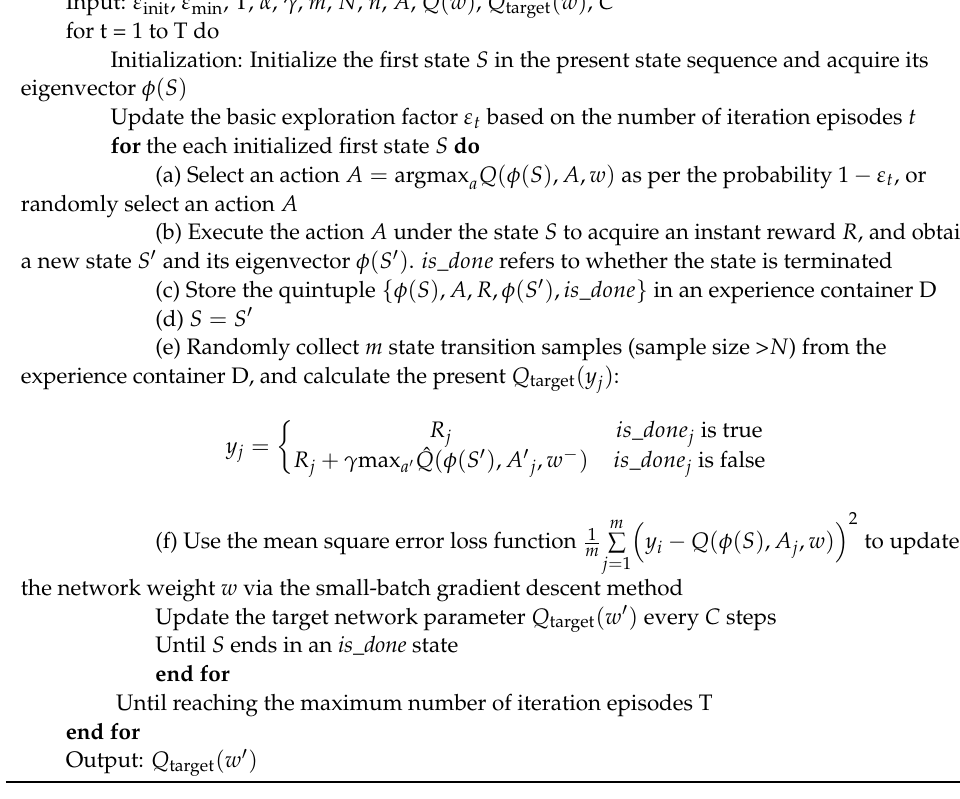
Algorithm 1: Pseudo form of the DQN